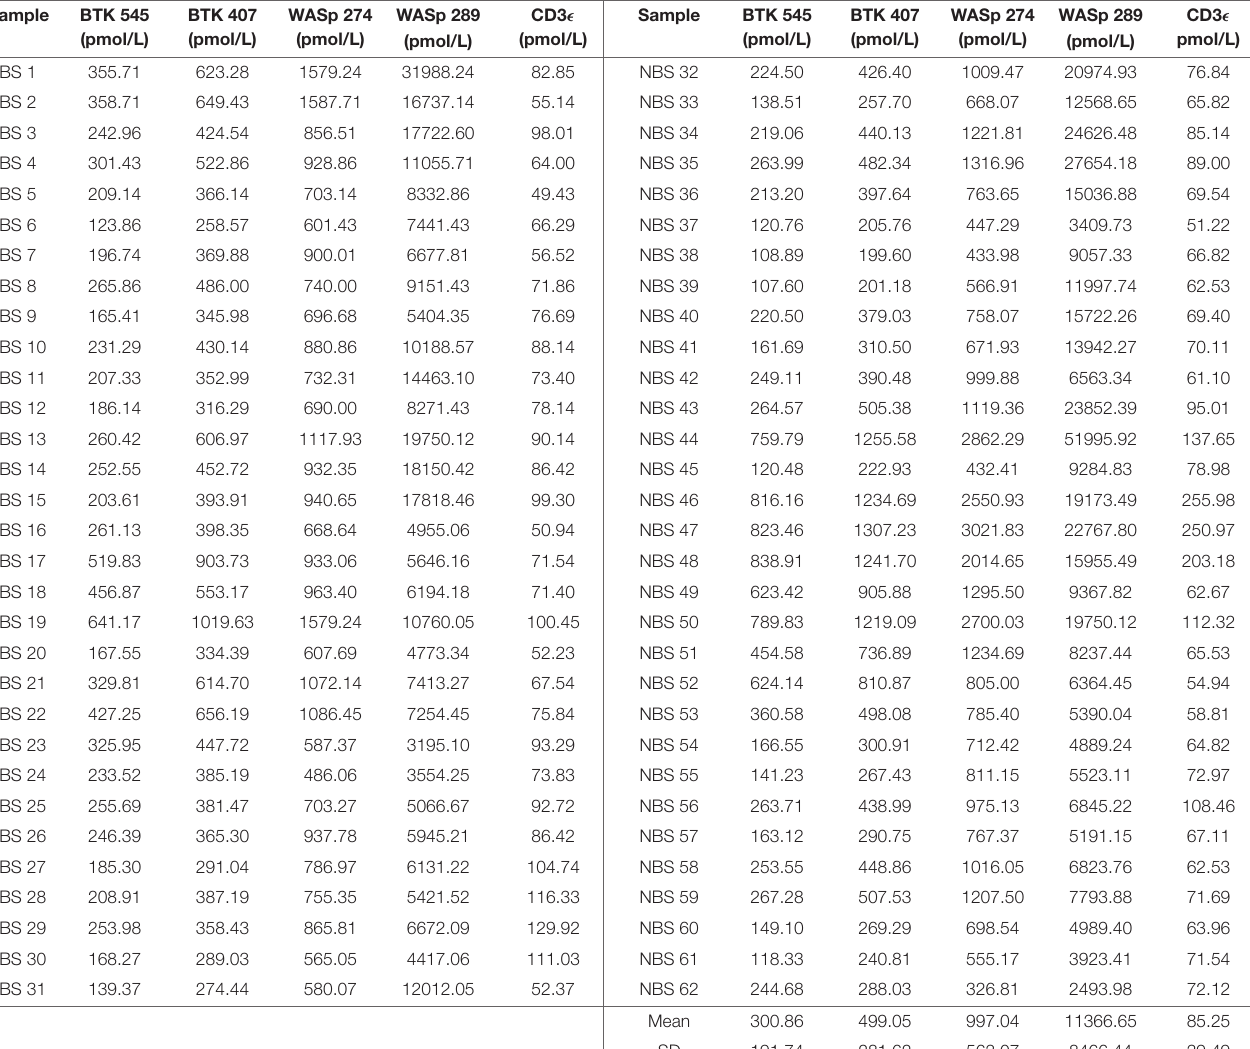
TABLE 7 | Signature peptides levels in DBS obtained from Washington State Newborn Screening Laboratory (Samples collected prior to March 2015).